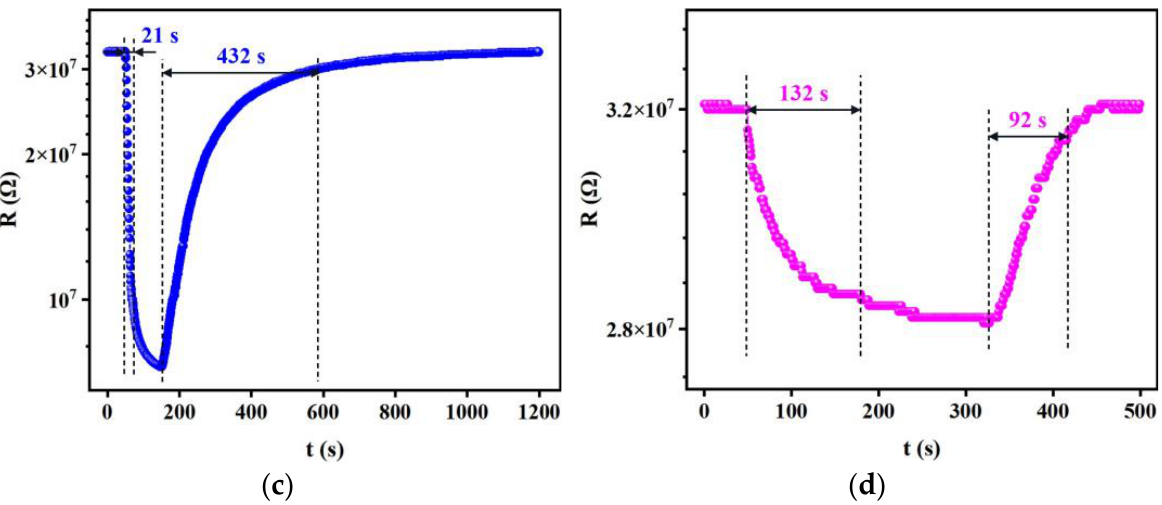
Figure 8. Recovery curves of the response of Sn/SnO 2 samples to different VOCs at 1000 ppm at 250 °C. ( a ) Methanol, ( b ) ethanol, ( c ) formaldehyde, and ( d ) acetone.